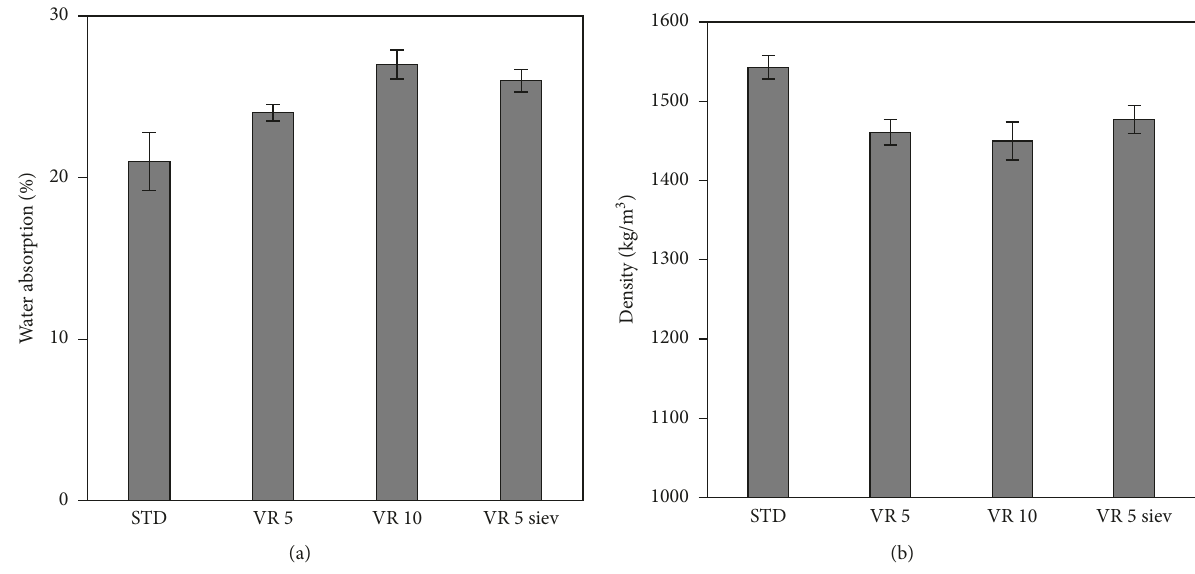
Figure 6: Water absorption (a) and bulk density (b) of